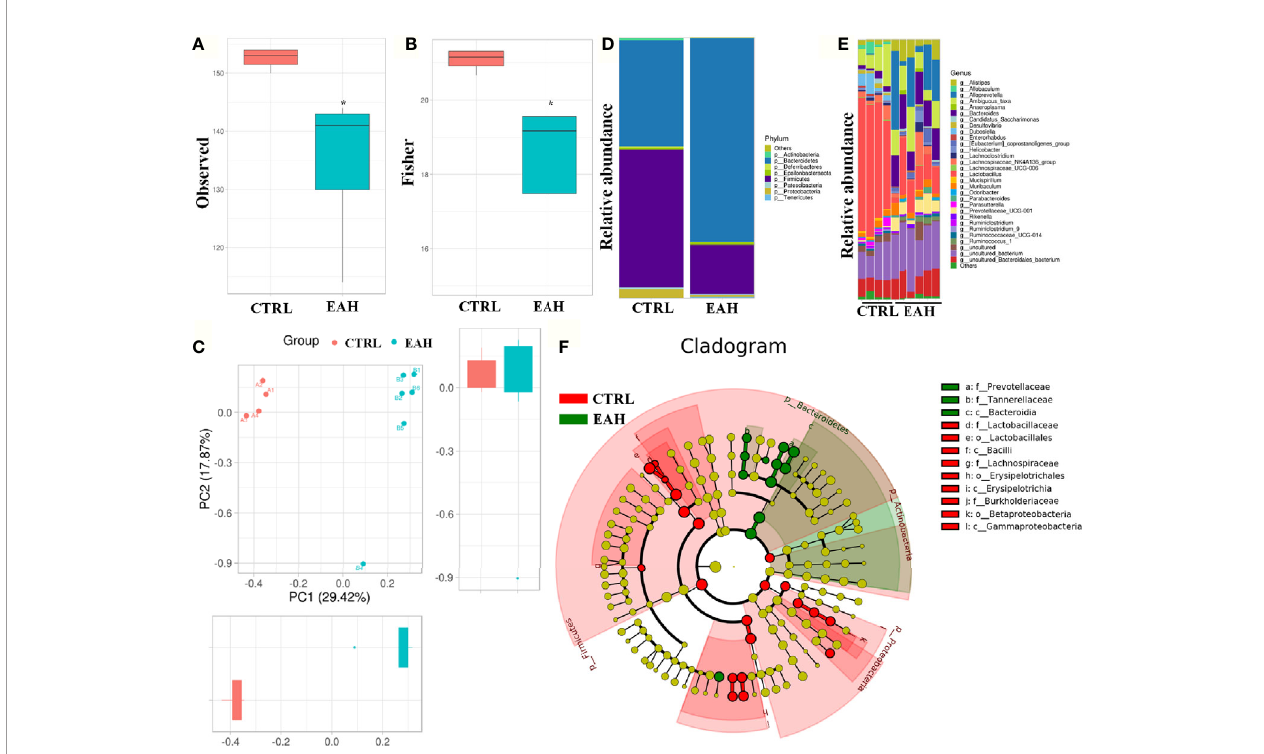
FIGURE 7 | Alteration of the gut microbiota composition in EAH mice. (A, B) Observed (A) and Fisher (B) diversity indexes of the gut microbiota in CTRL group (n=4) and EAH group (n=6). (C) ANOSIM based on weighted UniFrac distances. (D) Bar charts of the gut microbiota composition at the phylum level in CTRL group and EAH group. (E) Bar charts of the gut microbiota composition at the genus level in each mouse. (F) Cladogram generated from the LEfSe. (*p <